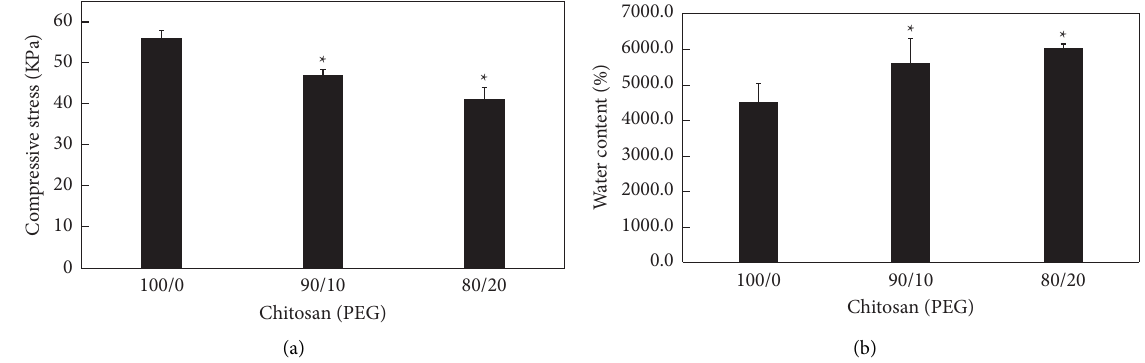
Figure 2: (a) Compressive modulus of CHI-100, CHI-90, and CHI-80 scafolds. Te values represent mean ± standard deviation, n � 4. ∗ indicates p < 0.05 vs. PEG-100 and PEG-90; PEG-100, and PEG-80. (b) Te dry-based water content of CHI-100, CHI-90, and CHI-80 scafolds. Te values represent mean ± standard deviation, n � 4. ∗ indicates p < 0.05 vs. PEG-100 and PEG-90; PEG-100, and PEG-80.